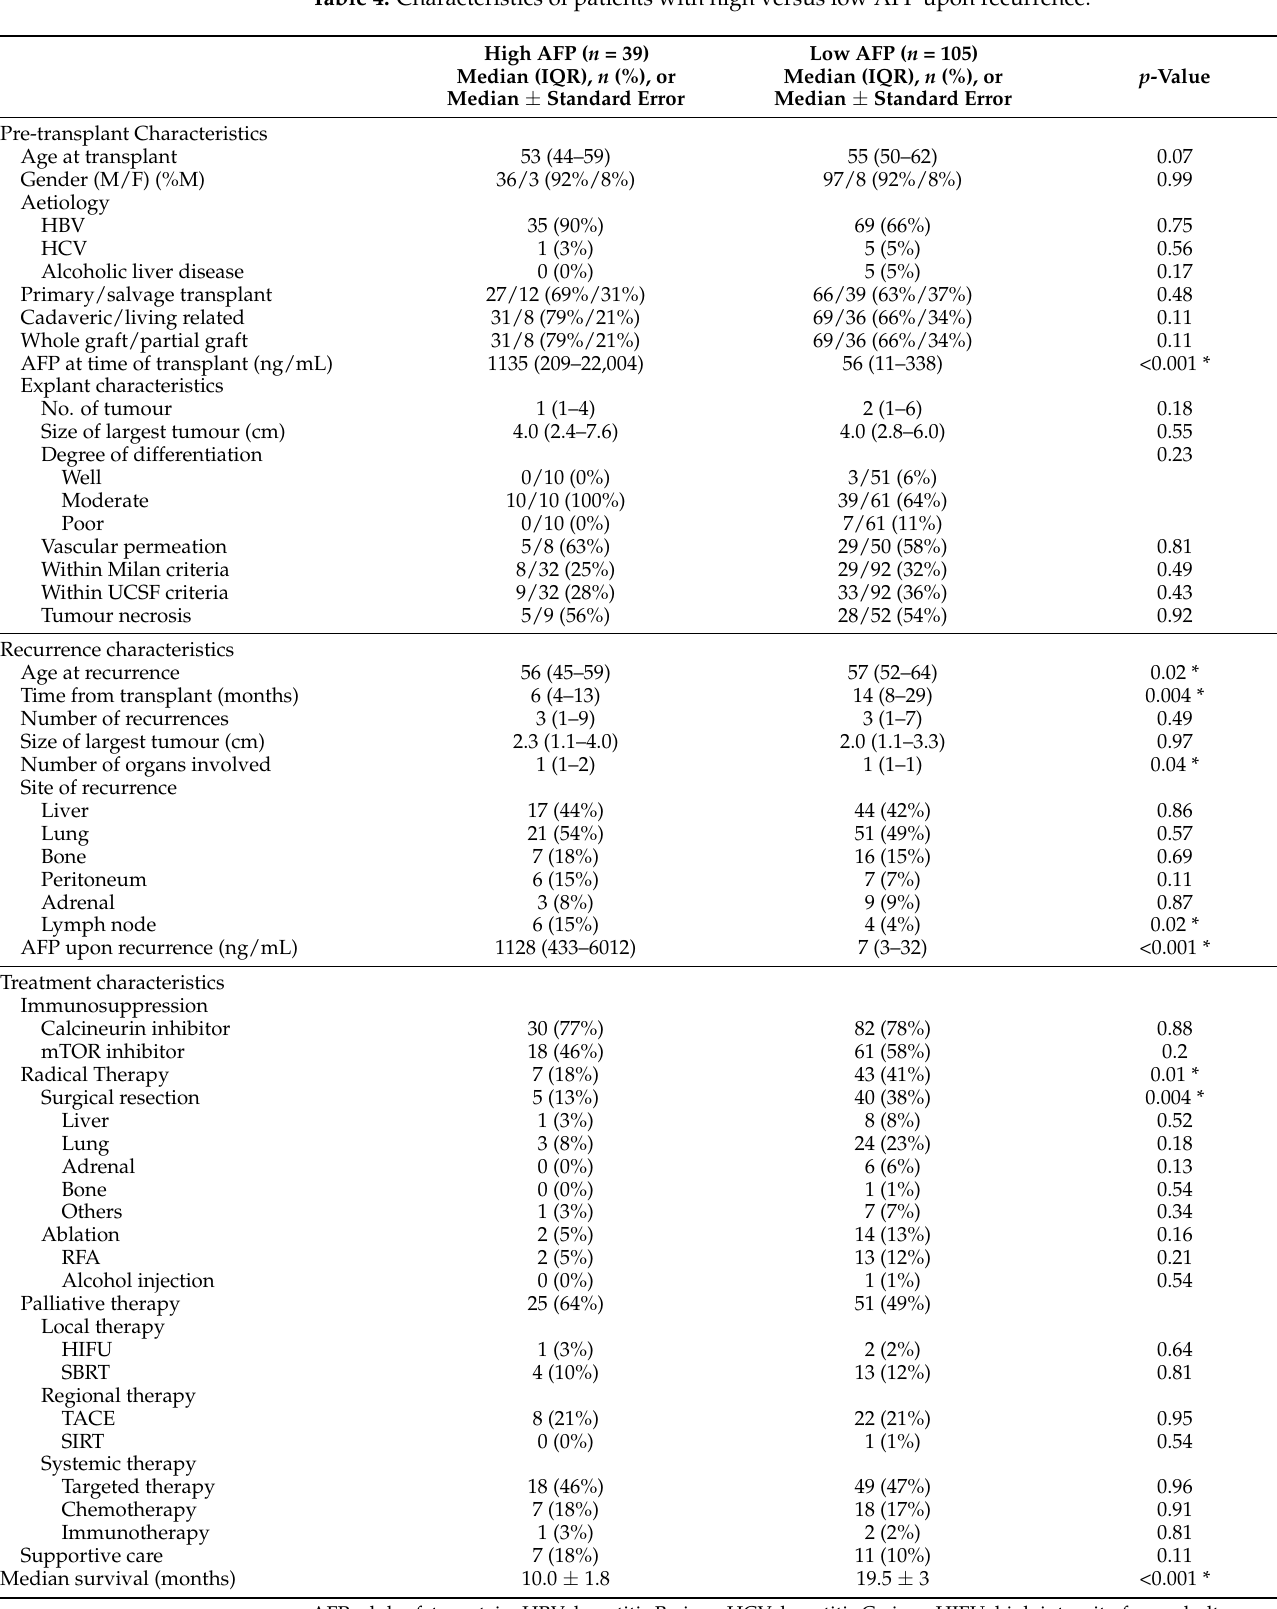
Table 4. Characteristics of patients with high versus low AFP upon